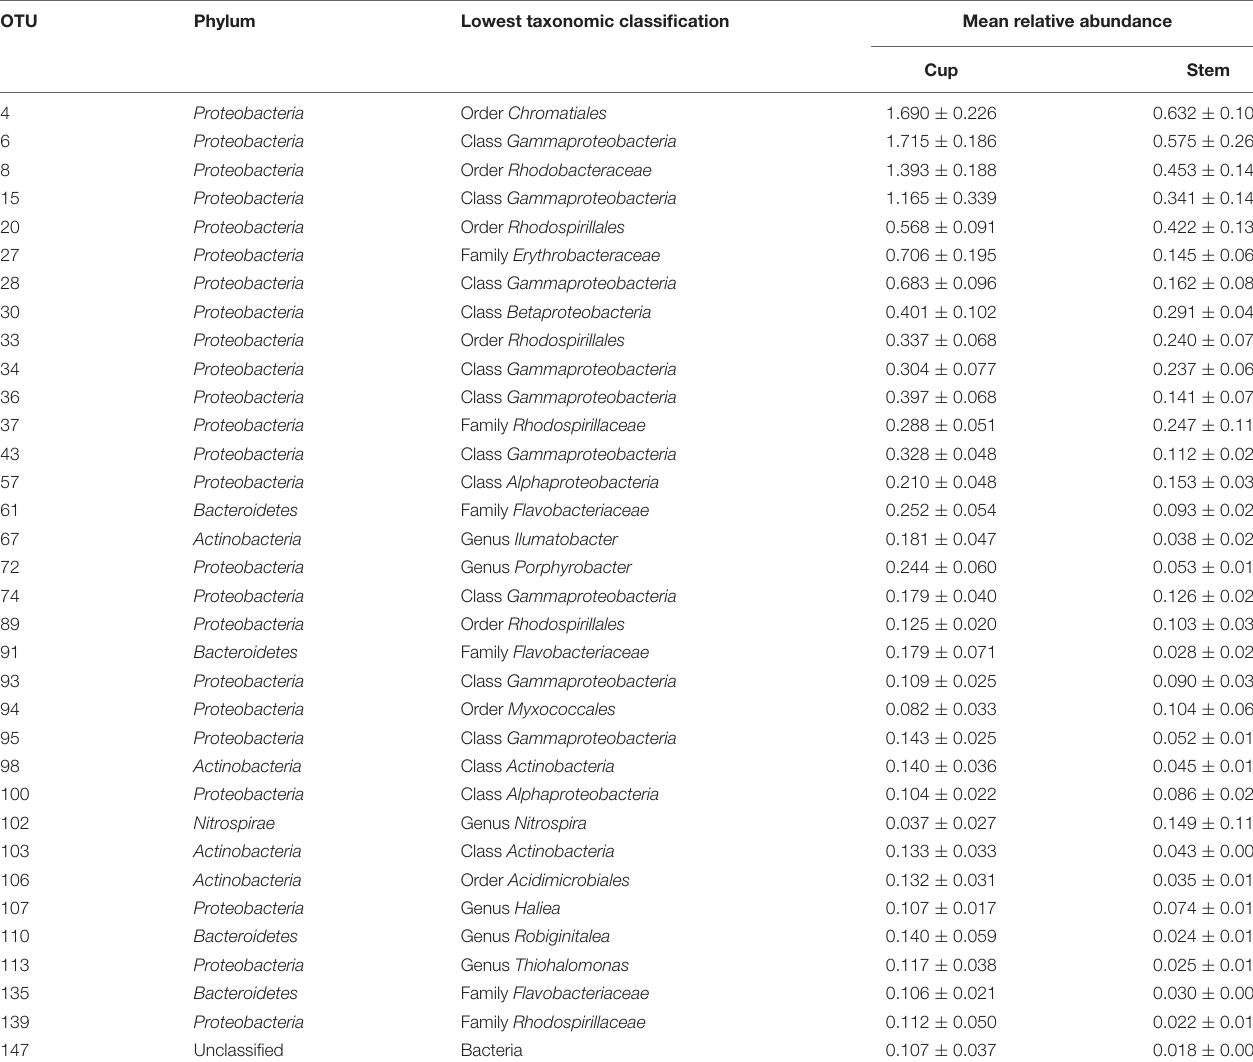
TABLE 3 | Highly abundant ( > 0.1 mean relative abundance of total community ± SD) OTUs identified as contributing significantly ( P < 0.01) to the differences between the cup and stem of Cliona patera . OTU Phylum Lowest taxonomic